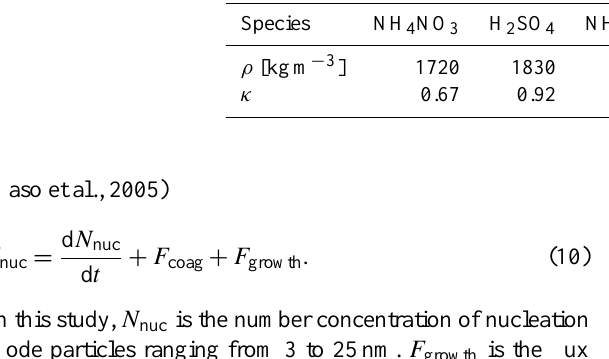
Table 2. Gravimetric densities ρ and hygroscopicity parameters κ